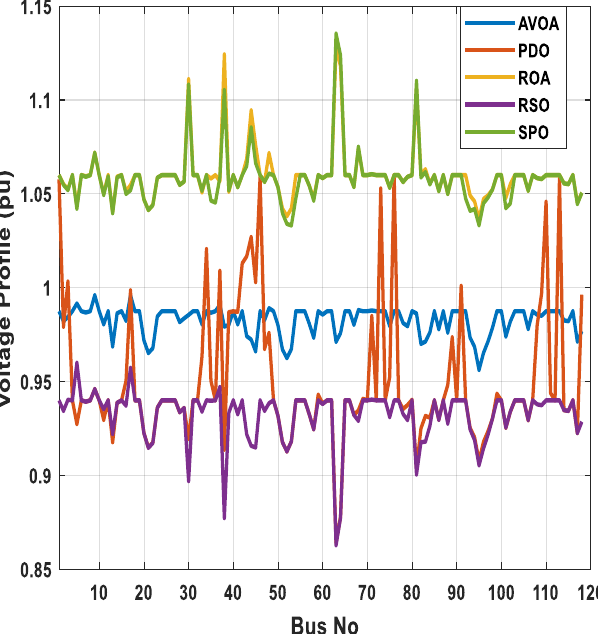
Figure 23. The AVOA voltage profile with the other compared methods for case 10. Table 24. Minimization of multi-objective functions (voltage-level deviation, operational cost, and transmission power loss) with discrete control variable settings in IEEE-118 bus.